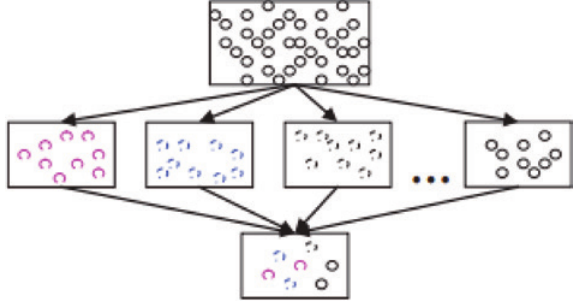
Figure 4: Parallel Grouping Search